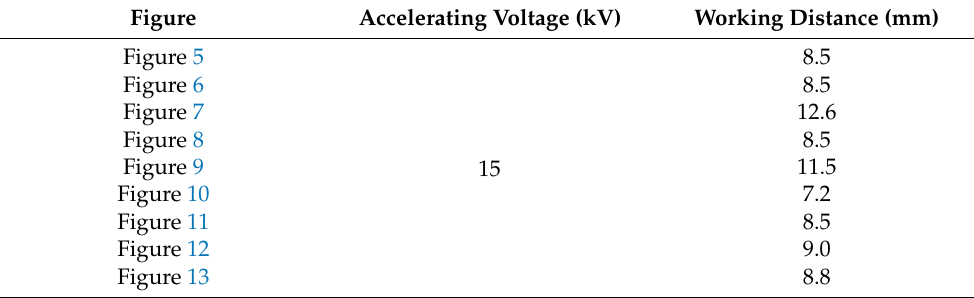
Table A4. SEM/EDS operating parameters in this